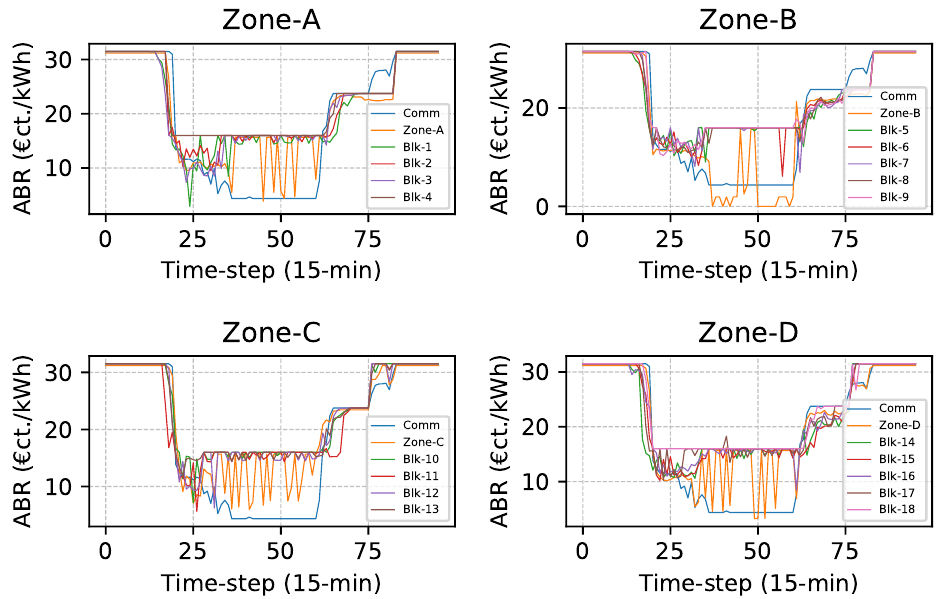
Figure 11. Community (sub-community) average trade price of Zone-A, Zone-B, Zone-C and Zone-D in multi-layer community model for a single